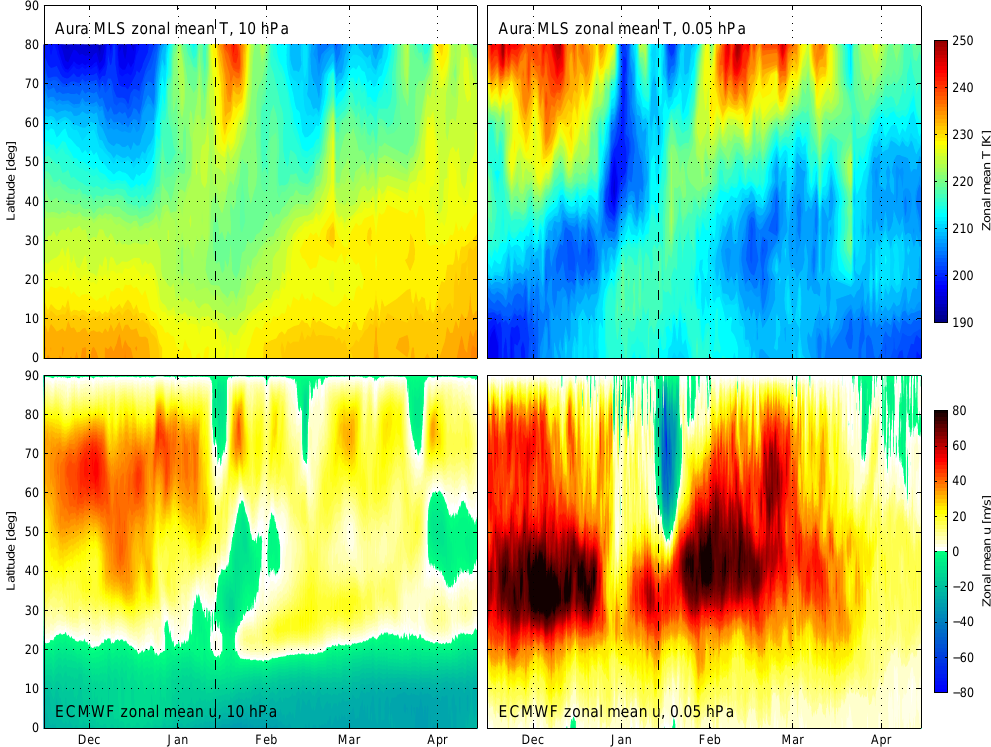
Figure 4. Zonal mean Aura MLS temperature (top panels) and ECMWF zonal wind (bottom panels) on 10hPa (left panels) and 0.05hPa (right panels) during boreal winter 2011/2012. The black dashed lines indicate the beginning of the SSW on 14 January, 2012.